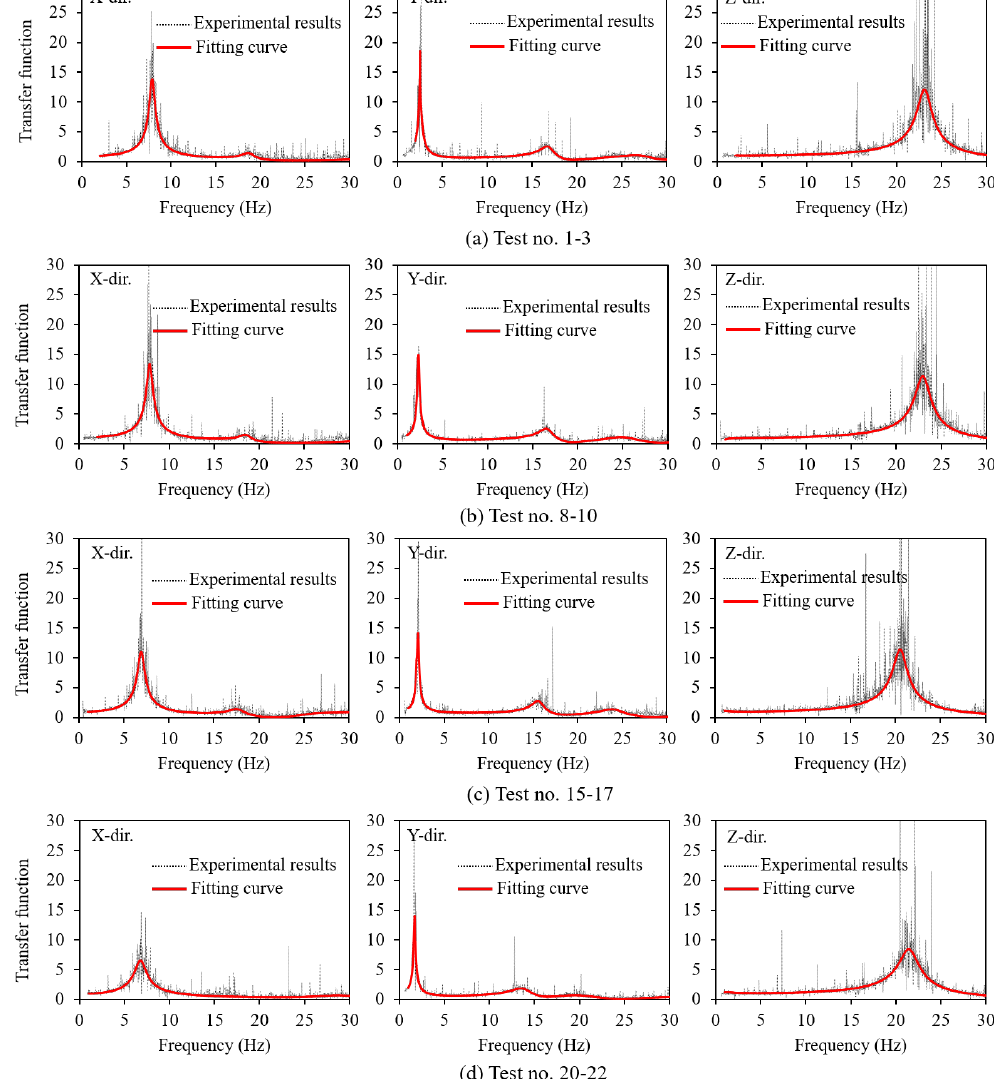
Figure 8. Transfer function amplitude versus frequency curves at top beam: ( a ) Test no.1 – 3; ( b ) Test no.8 – 10; ( c ) Test no.15 – 17; ( d ) Test no.20 – 22.